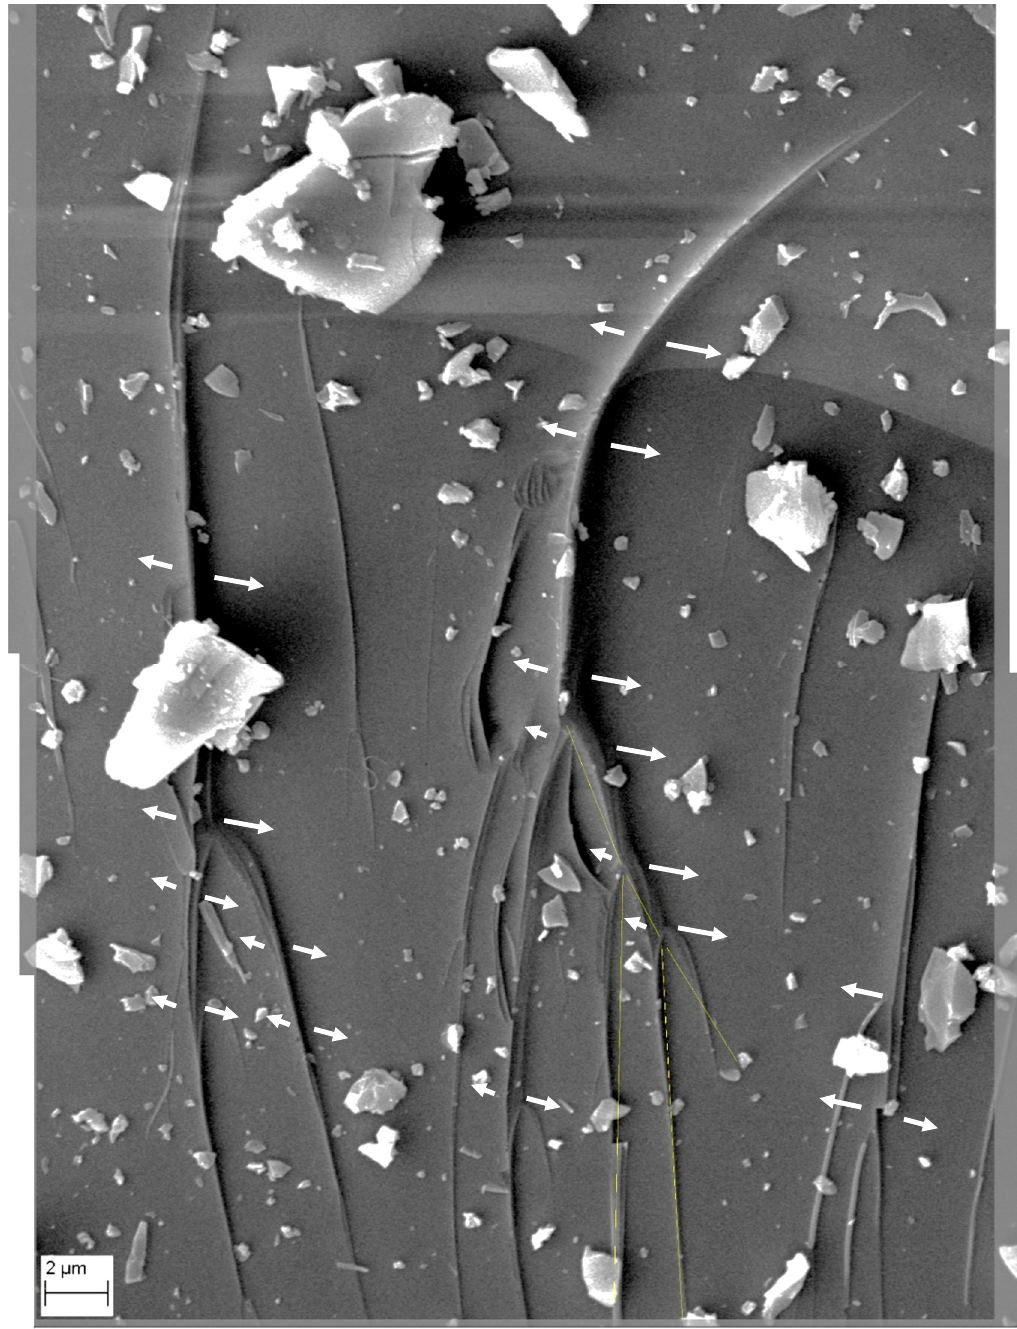
Figure 6. Fractures on the surface of a quartz granule subjected to 100 MPa; the bifurcations show angles of about 27° (taken from the work of Martinelli et al. [5]).